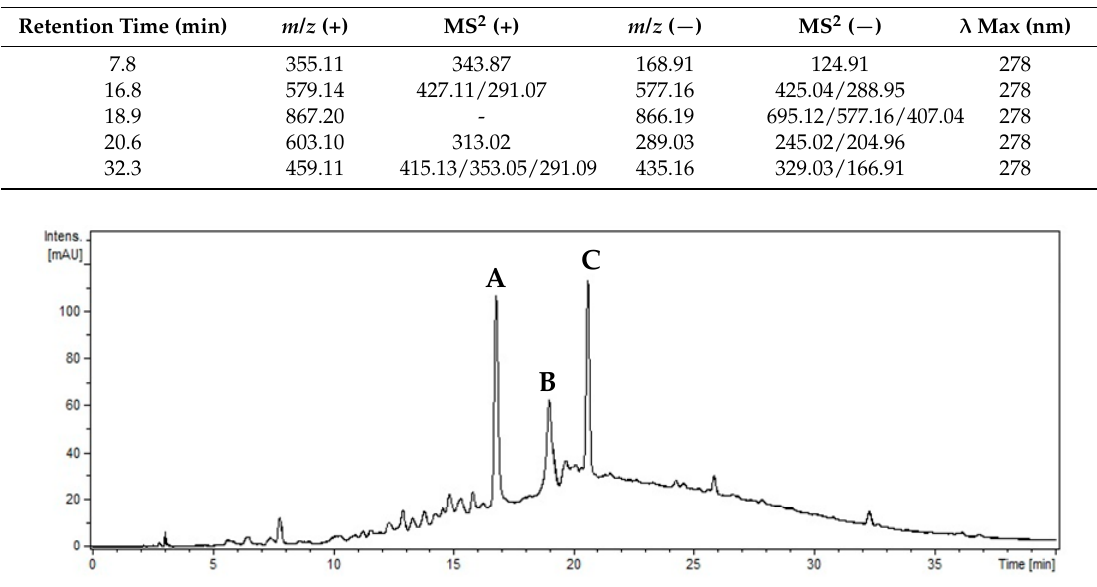
Figure 1. Chromatogram of X. americana extract at 270 nm. ( A ) Procyanidin B; ( B ) Procyanidin C; ( C ) Catechin/epicatechin.